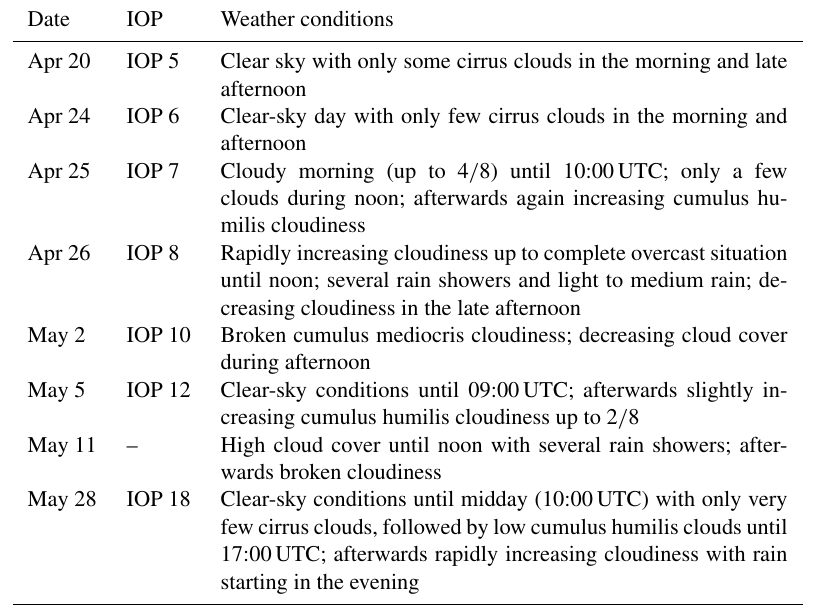
Table 5. Days of HOPE for which runs of the ICON model are available. Date IOP Weather conditions Apr 20 IOP 5 Clear sky with only some cirrus clouds in the morning and late afternoon Apr 24 IOP 6 Clear-sky day with only few cirrus clouds in the morning and afternoon Apr 25 IOP 7 Cloudy morning (up to 4 / 8) until 10:00UTC; only a few clouds during noon; afterwards again increasing cumulus